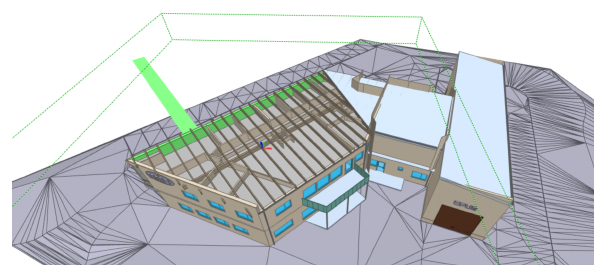
Figure 3. Myran model as exported by Autocad Civil. A part of the wall is protruding with completely irregular behaviour.